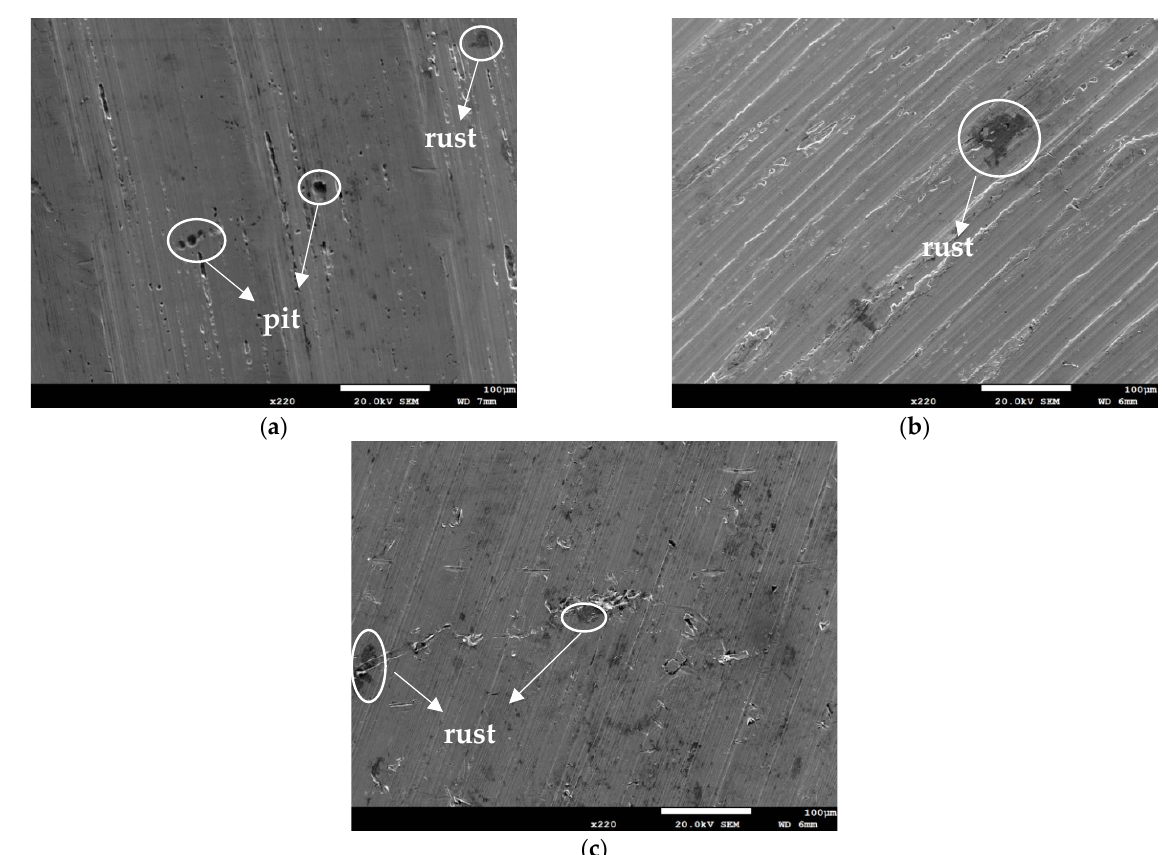
Figure 6. SEM micrographs of those specimens with a 0.1 g/m 2 chloride concentration at: ( a ) Relative humidity = 45%, ( b ) relative humidity = 55%, and ( c ) relative humidity = 70%.